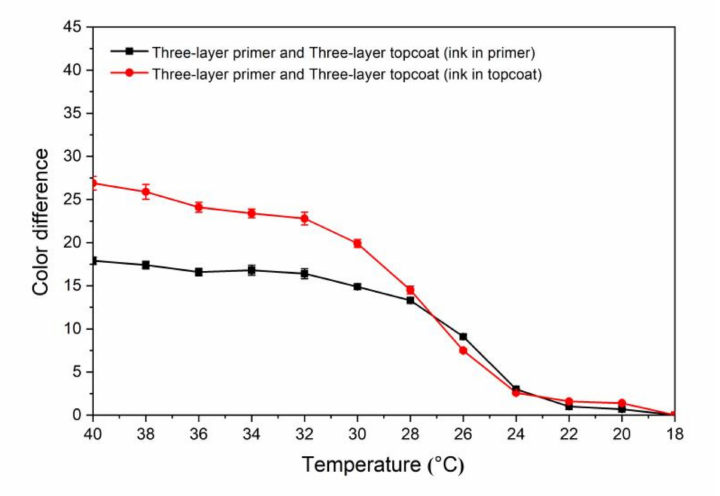
Figure 8. Change of color di ff erence of waterborne coating on Chinese fir surface at